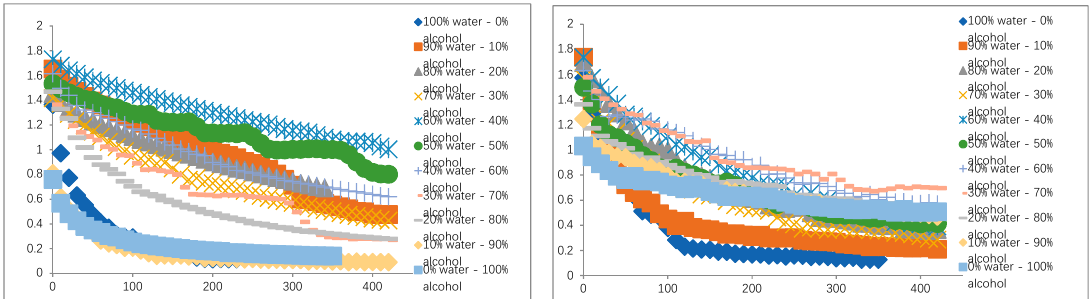
Figure 1. Absorbance variation in time for solutions containing water/isopropyl alcohol (left) and water/tert-Butyl alcohol